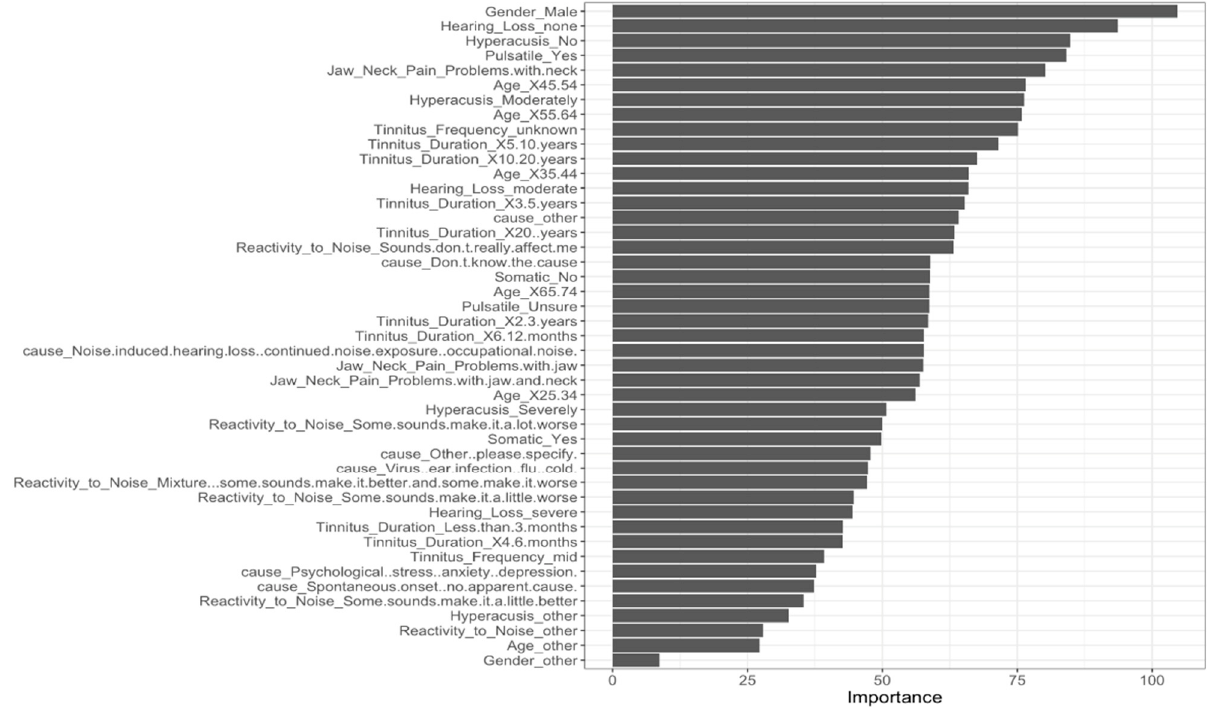
Figure 3. Variables most significantly affecting classification.